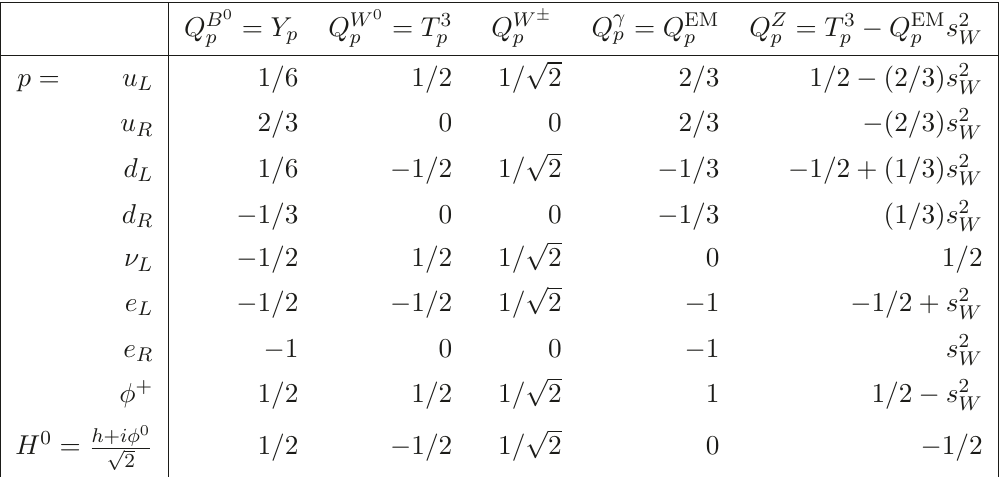
Table 8. Gauge charges of chiral fermions and scalars in the Standard Model. For the fermions, first generation is used, but charges for second and third generations follow the same